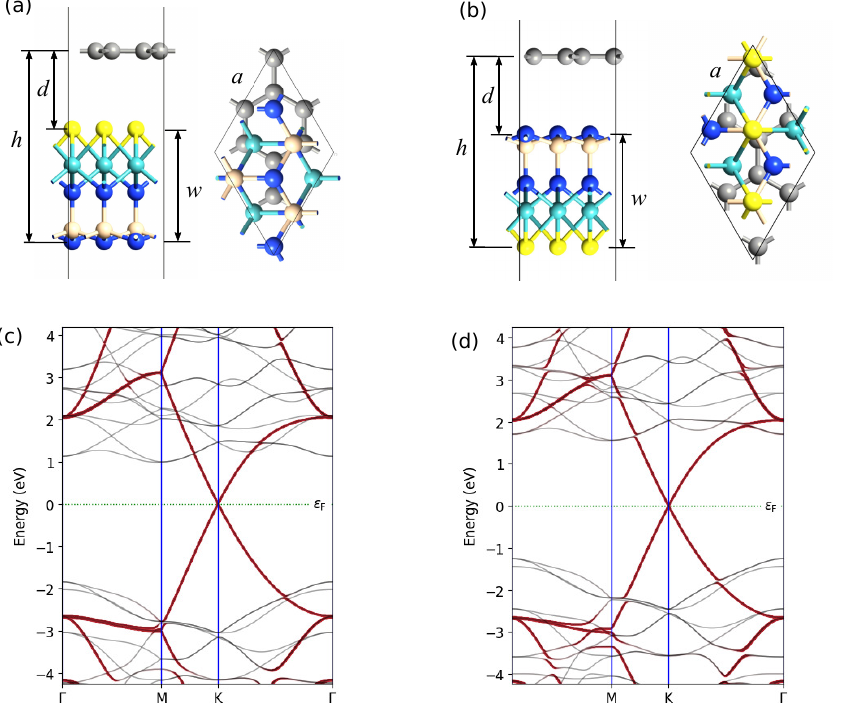
Figure 9. Geometry of vdW heterostructure S-MoSiN 2 /graphene and graphene/S-MoSiN 2 ( a , b ) and their bandstructures ( c , d ). The brown lines correspond to the contribution of carbon.